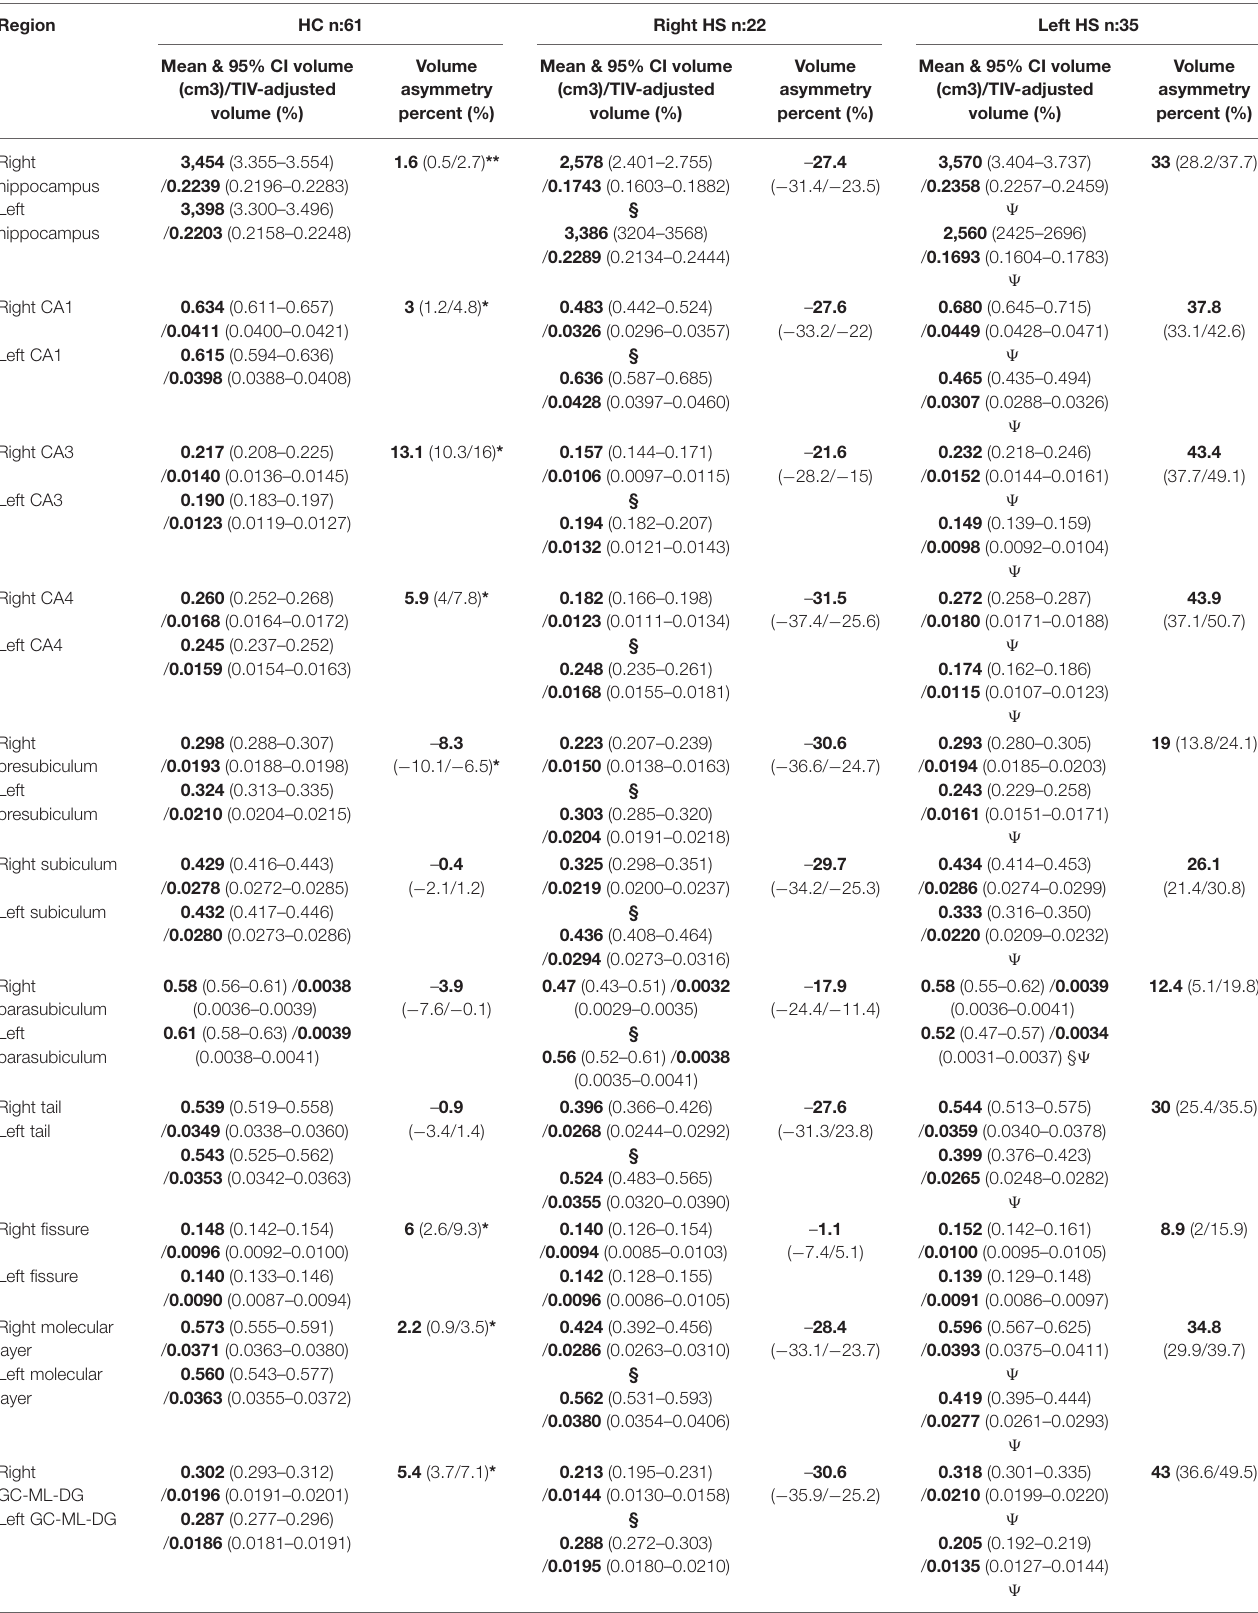
TABLE 2 | FreeSurfer v6.0